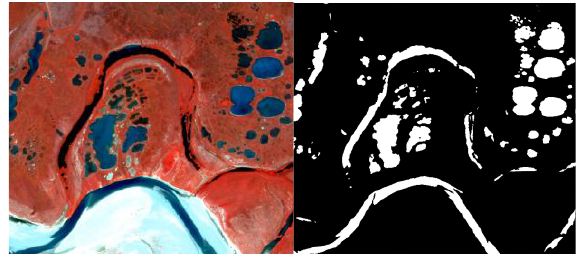
Figure 3. (a) A zoomed sample satellite image with water bodies. (b) The zoomed calculated water bodies by the workflow where water bodies are represented by black. Imagery © 2016 DigitalGlobe, Inc